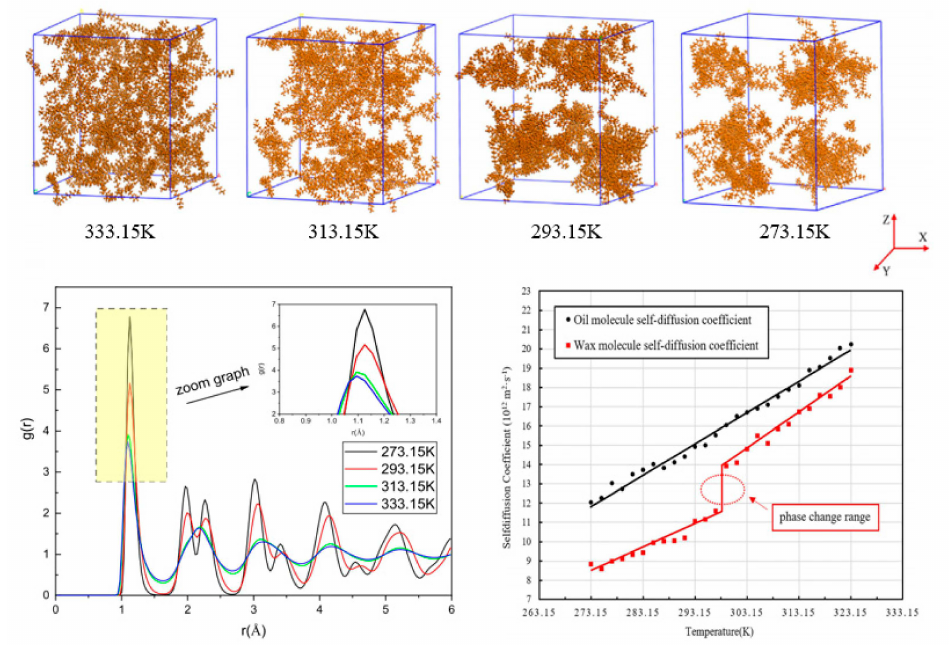
Figure 11. Schematic diagram of molecular dynamics characterization of precipitation behavior of wax molecules